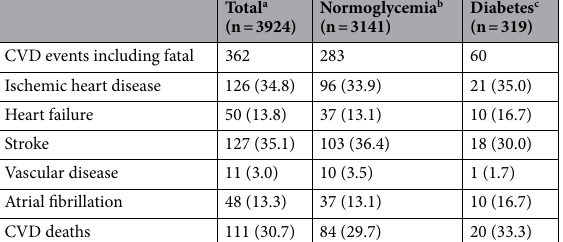
Table 2. Cardiovascular outcomes. Data are n and (%) of “CVD events including fatal”. a 203 with prior CVD events excluded. b 464 participants missing OGTT data excluded. c Diabetes is both screen-detected and self- reported.